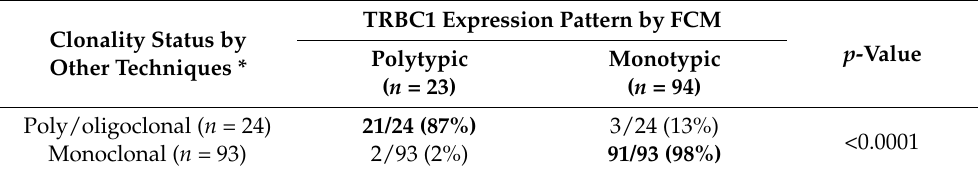
Table 4. Comparison between TRBC1 assay by FCM and the reference molecular and FCM techniques used to assess T αβ -cell clonality ( n =